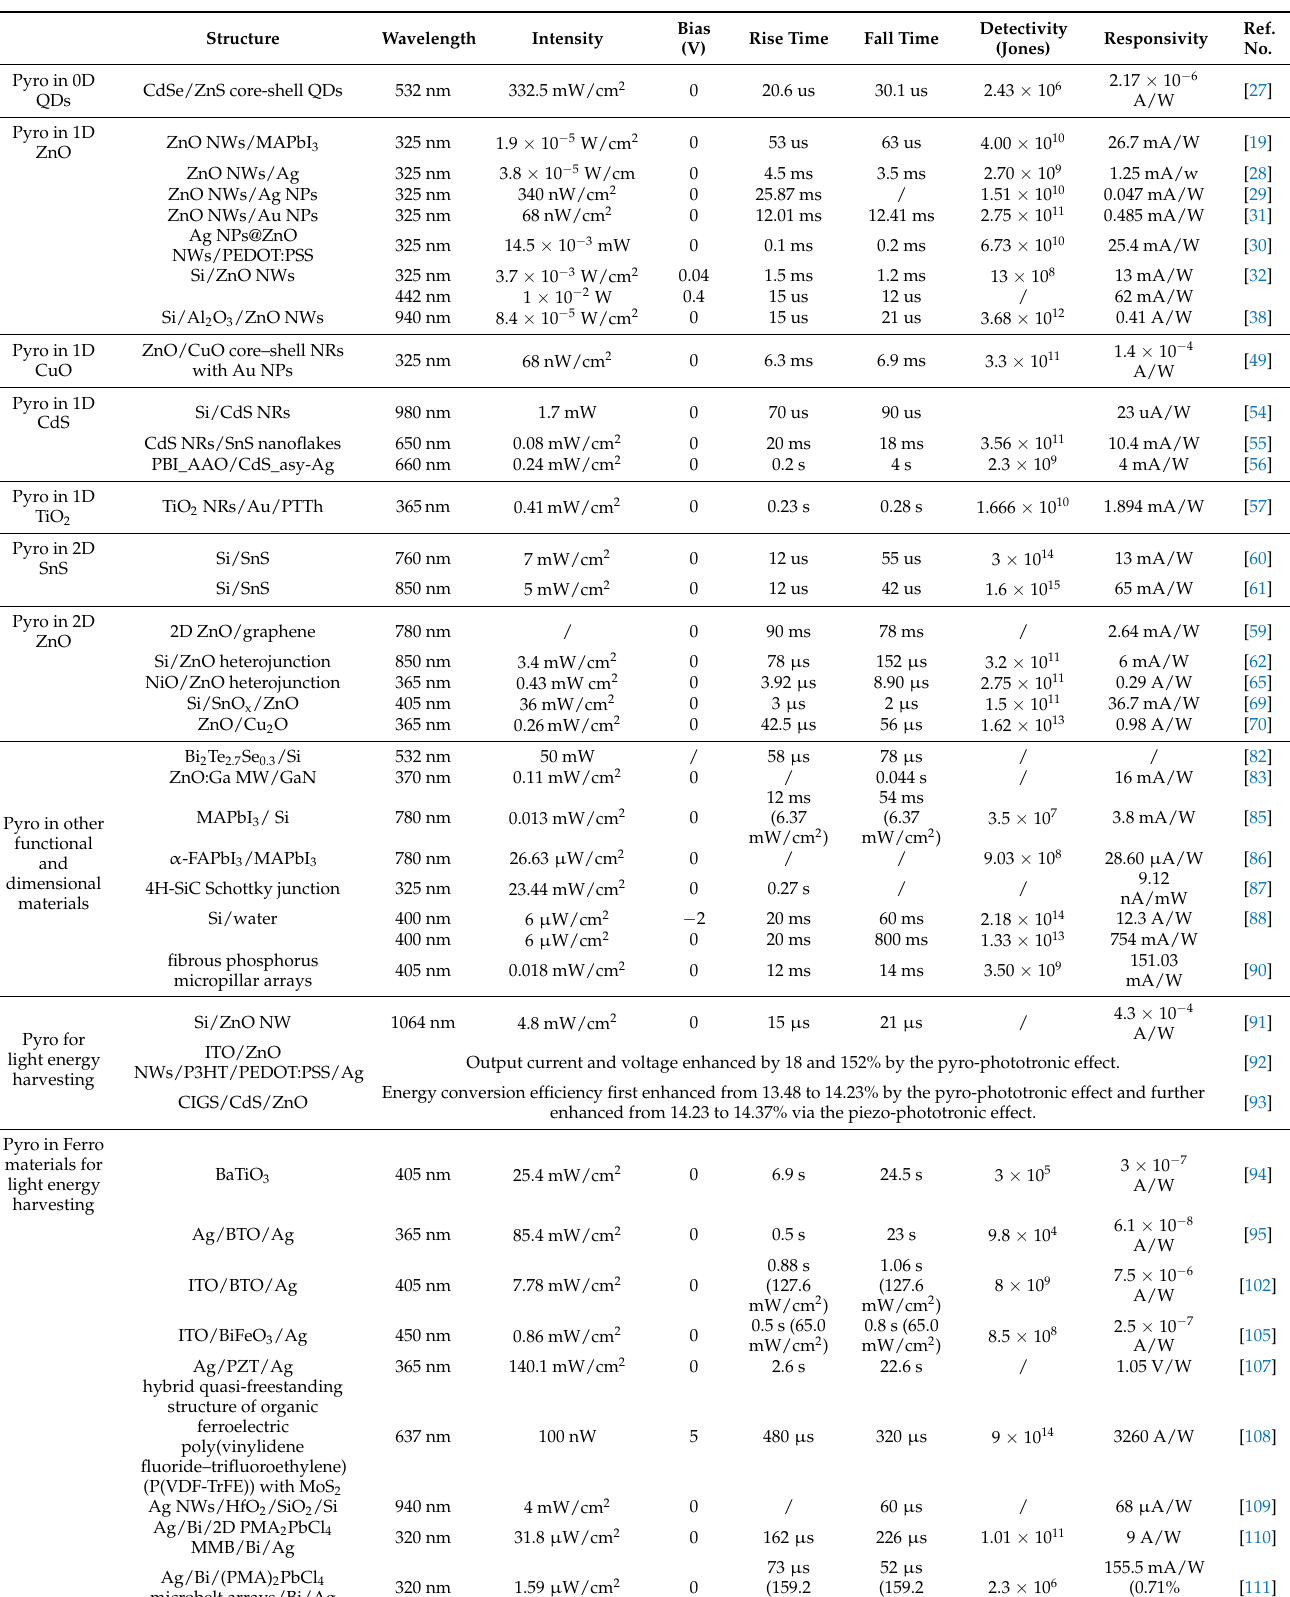
Table 1. Comparison of performances of pyro-phototronic-effect-enhanced photodetectors and light energy